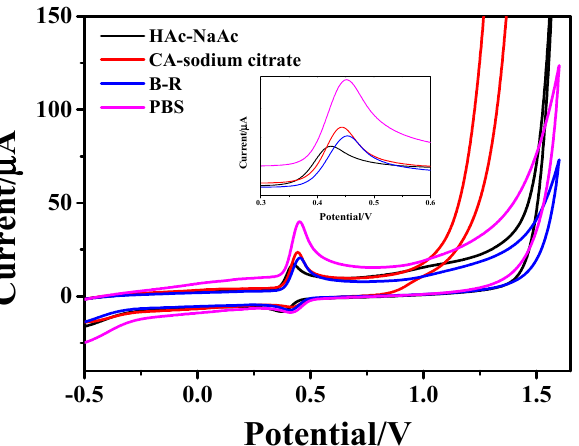
Figure 4. CV curves of 1 × 10 − 4 M AC on Fe 3 O 4 -rGO/GCE electrodes at a scan rate of 100 mV·s − 1 in different buffer solutions: PBS (pH = 5.6), B-R (pH = 5.0), CA-sodium citrate (pH = 5.0) and Hac- NaAc (pH = 5.5).